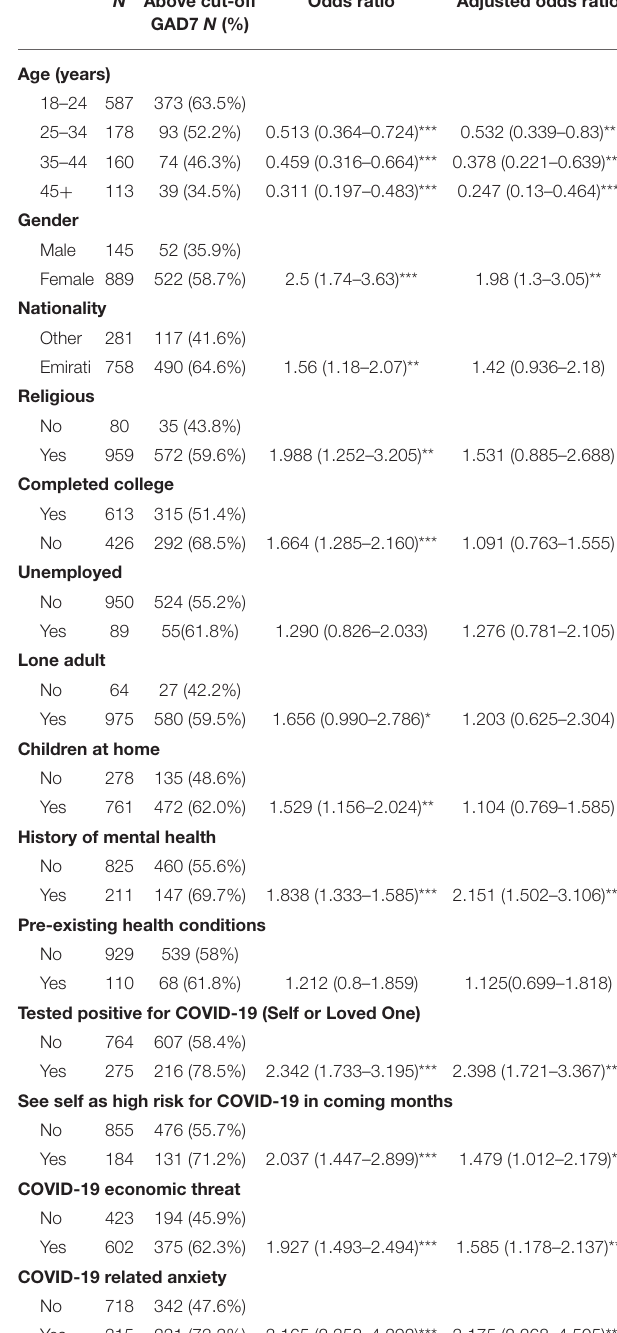
TABLE 6 | Bivariate (OR) and multivariate (AOR) logistic regression predicting GAD7 anxiety symptom scores above cut-off. N Above cut-off GAD7 N